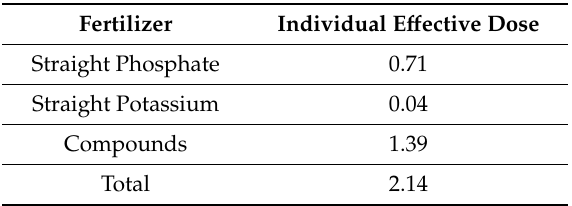
Table 6. Annual individual effective dose (µSv/a) after one hundred years of fertilizer spreading on the same agriculture area in the region of Veneto.